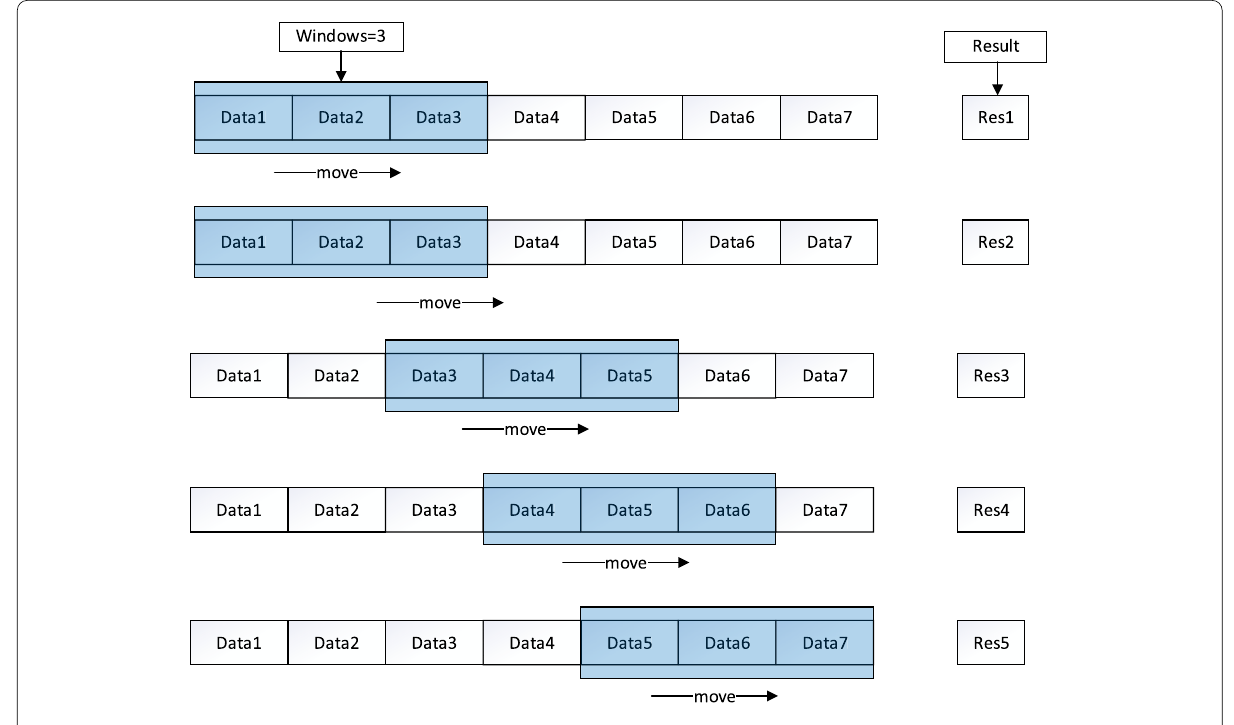
Figure 2 The sliding window approach